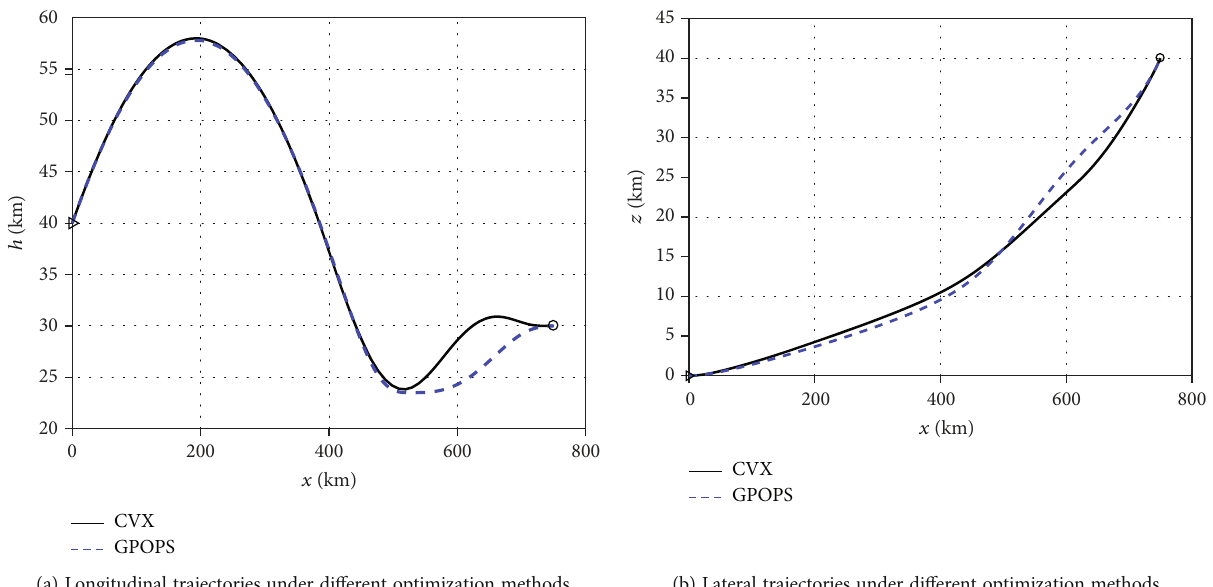
Figure 15: Trajectories under di ff erent optimization methods.